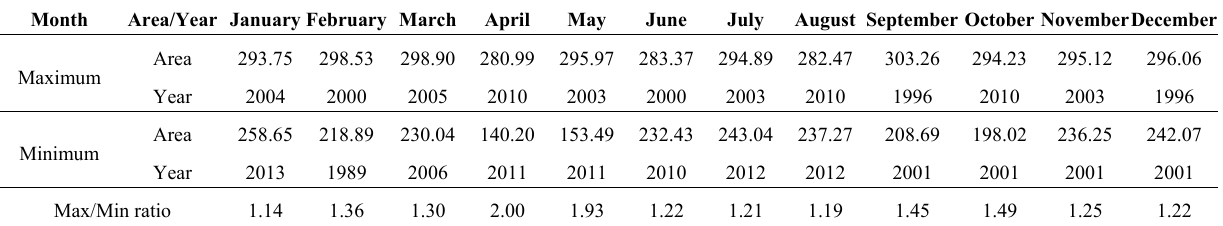
Table 1. Inter-Annual variability of area of the Honghu Lake (km 2 ) by month from the 1990s to 2013.